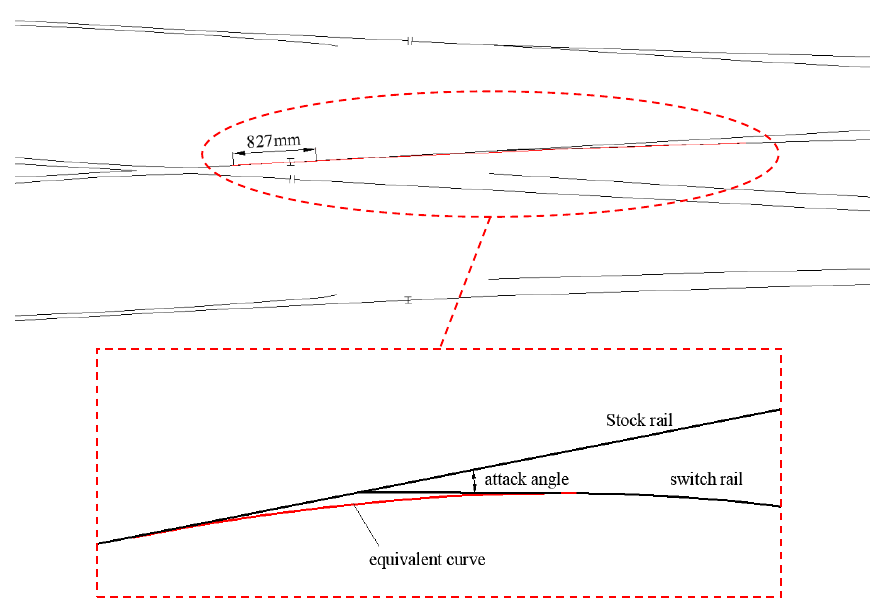
Figure 16. Broken-line rail composed of switch rail and stock rail and its equivalent